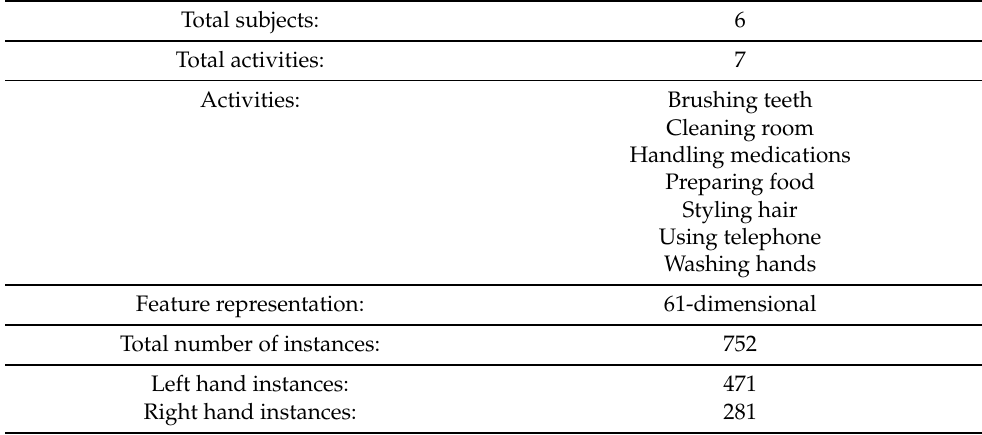
Table 2. Details of composite activities in the CogAge dataset [15]. The left hand represents the number of instances in which the activities are mainly performed using the left hand only, whereas, in the both hands setting, the activities are performed using both